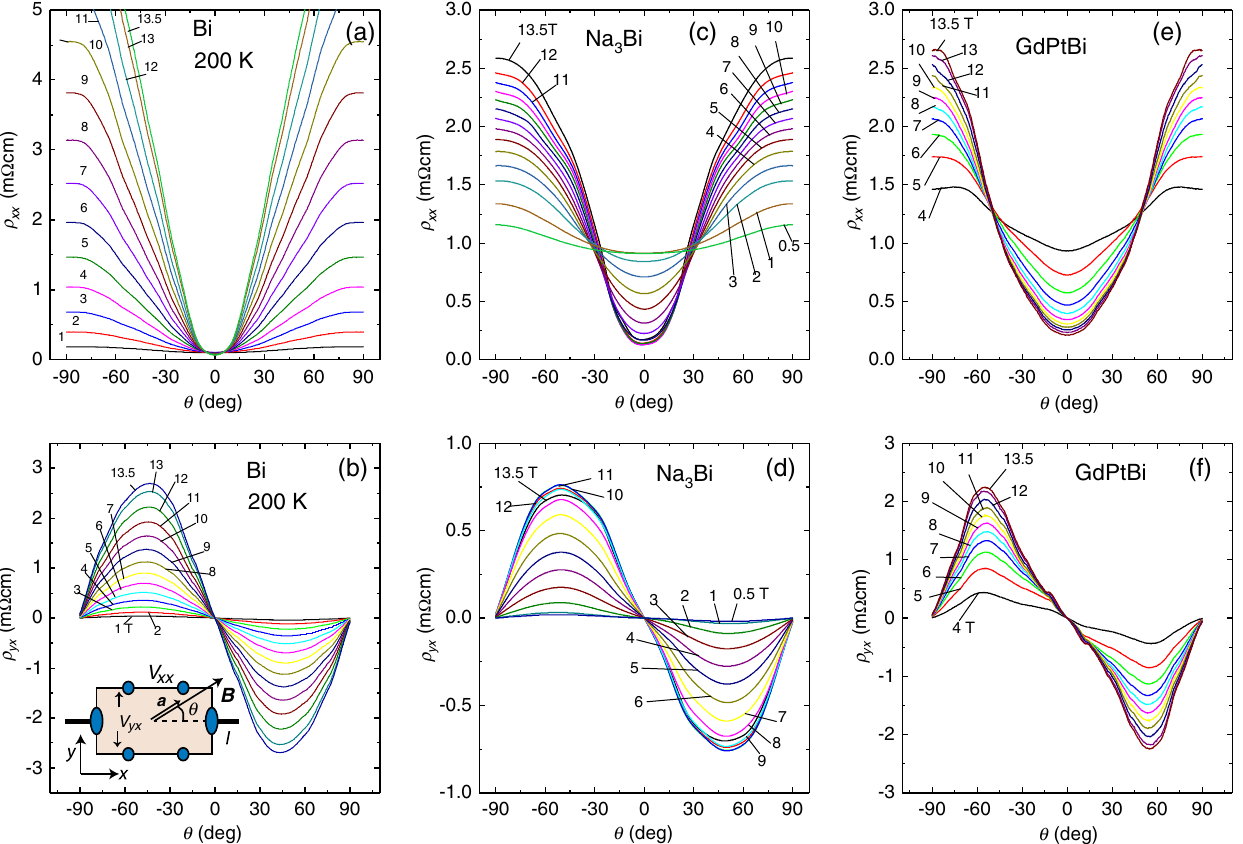
FIG. 7. Planar AMR measurements in Bi, Na 3 Bi, and GdPtBi. Panels (a) and (b) show the θ dependence of the diagonal and off- diagonal AMR signals, expressed as effective resistivities ρ xx and ρ yx , respectively, in Bi (sample B2) at 200 K. In panel (a), ρ xx decreases with increasing B when θ ¼ 0 (spurious LMR produced by current jetting). When j θ j exceeds 20°, ρ xx increases steeply with both j θ j and B . In absolute terms, the increase in ρ xx at θ ¼ 90 ° far exceeds its decrease at θ ¼ 0 . The off-diagonal MR ρ yx follows the standard sin θ : cos θ variation [panel (b)]. Panel (c) shows curves of ρ xx for Na 3 Bi (sample N2) at 4 K. The decrease in ρ xx at θ ¼ 0 is roughly comparable with the increase at 90°. A similar balanced pattern is observed in GdPtBi (sample G1) measured at 2 K [panel (e)]. In both case 2 systems, the comparable changes in ρ xx measured at 0° and 90° contrast with the lopsided changes seen in Bi (case 1). The off-diagonal ρ yx in both Na 3 Bi and GdPtBi [panels (d) and (f)] show the standard sin θ : cos θ profile. The profiles in panel (f) are distorted by anisotropic features associated with the creation of the Weyl pockets. The inset in panel (b) shows the sample geometry with a k B , both at the tilt angle θ to ˆ x